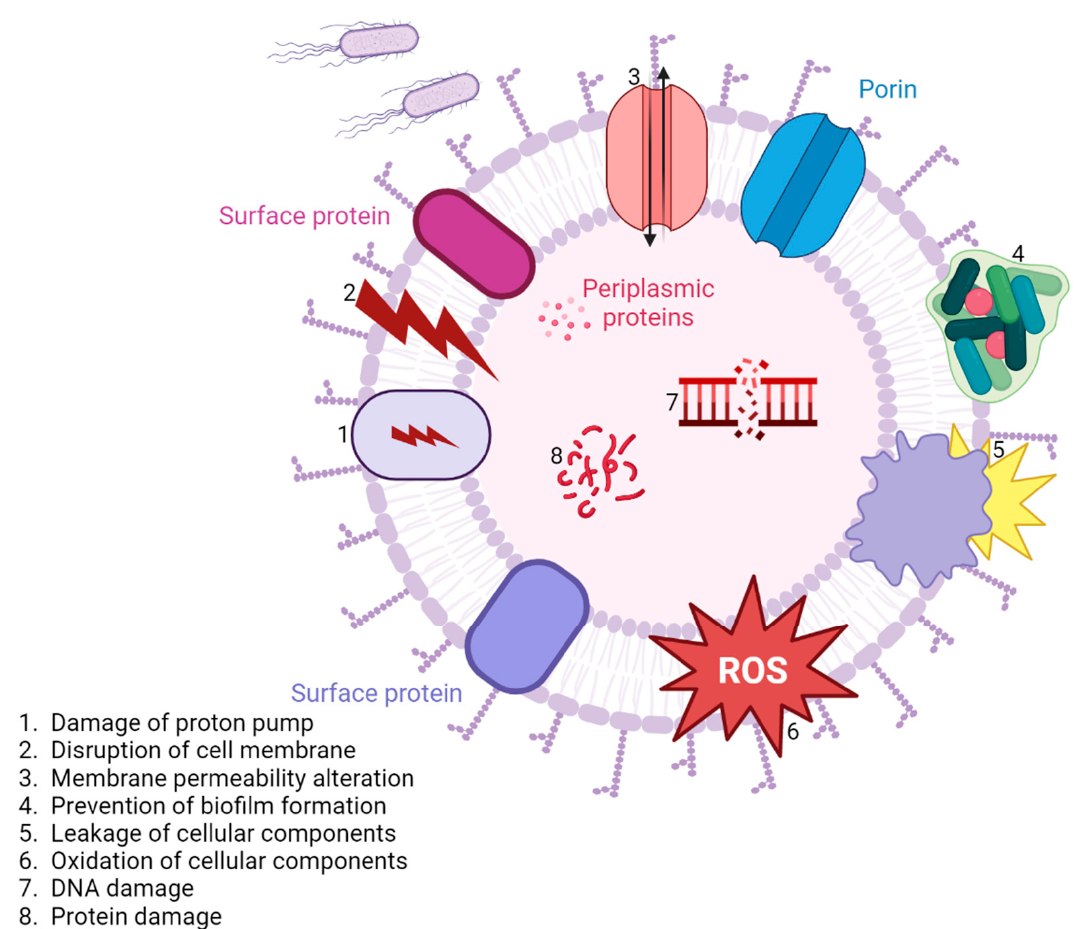
Figure 6. Nanoparticles—common mechanisms of action against UTIs.